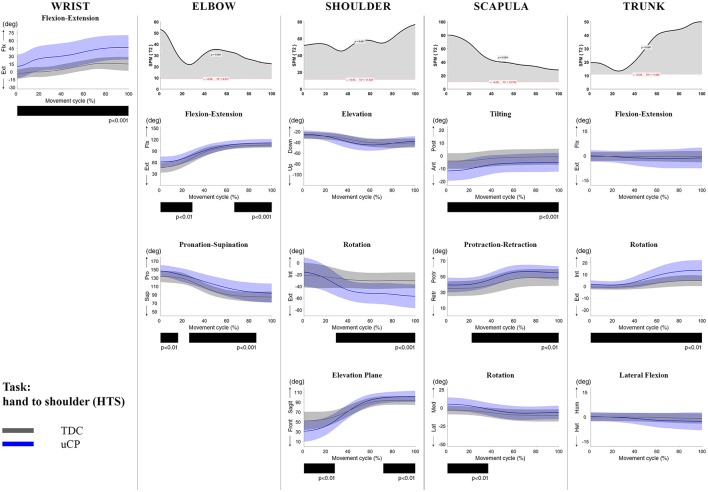
Comparison between children with uCP and TDC during the HTS task for all joint angles. Each column corresponds to a joint (from left to right: wrist, elbow, shoulder, scapula, and trunk). The top image of each column is the SPM output of the vector field analysis (Hoteling's test, except for the wrist, where a t-test was computed). Below, mean (bold line) and standard deviation (translucent area) of the TDC (gray) and uCP (blue) of each vector component, and the respective post-hoc SPM{t} output. The black bar under each kinematic profile indicates clusters of significant difference between groups.